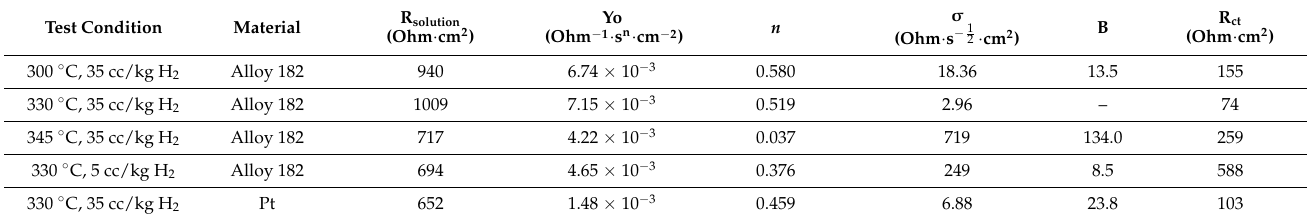
Figure 6. Nyquist diagrams after eight days of testing. Table 3. Fit results of the equivalent circuit model after eight days of testing.